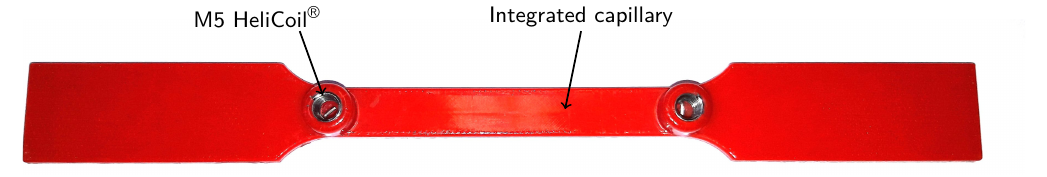
Figure 2. 3D printed tensile test